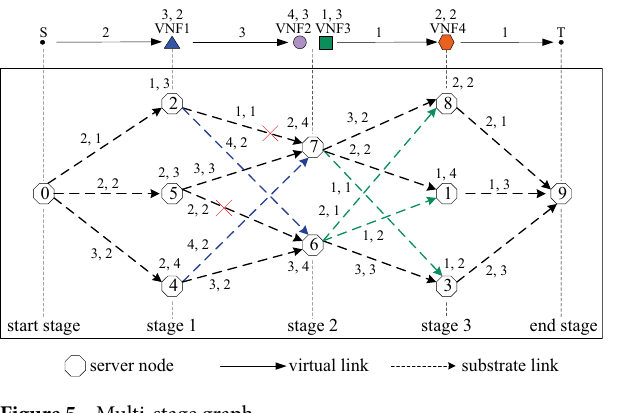
Figure 5. Multi-stage